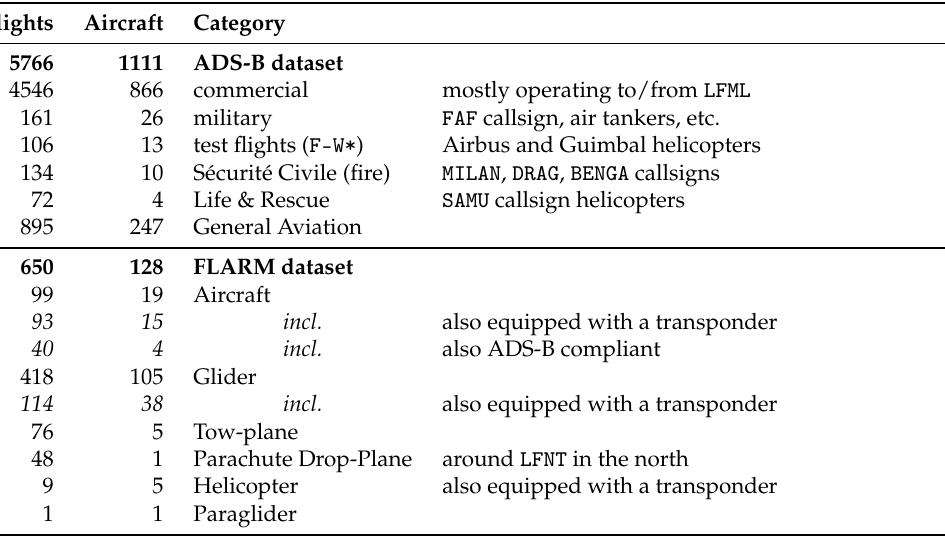
Table 2. The ADS-B and FLARM datasets cover a wide range of activities: commercial, military, test flights by manufacturers, ambulance (Life and Rescue), firefighting, General Aviation including ultralights and gliders. Four aircraft have been detected in both